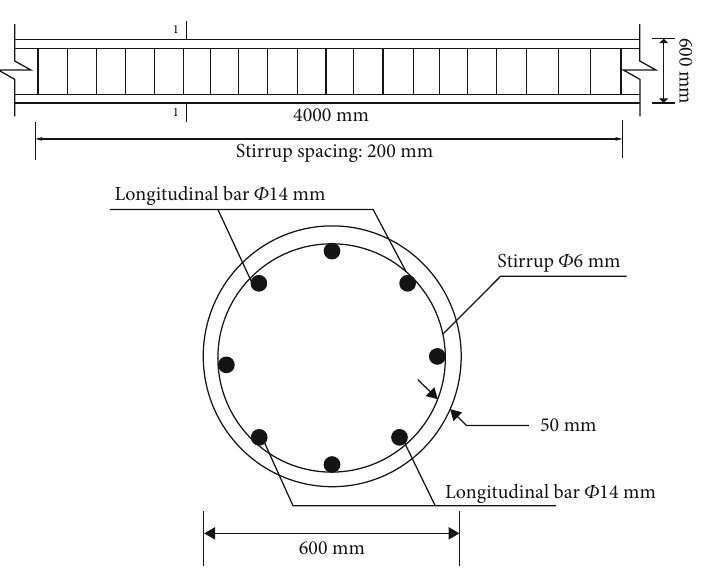
Figure 7: Circular pile size and reinforcement map of concrete (1-1 section).